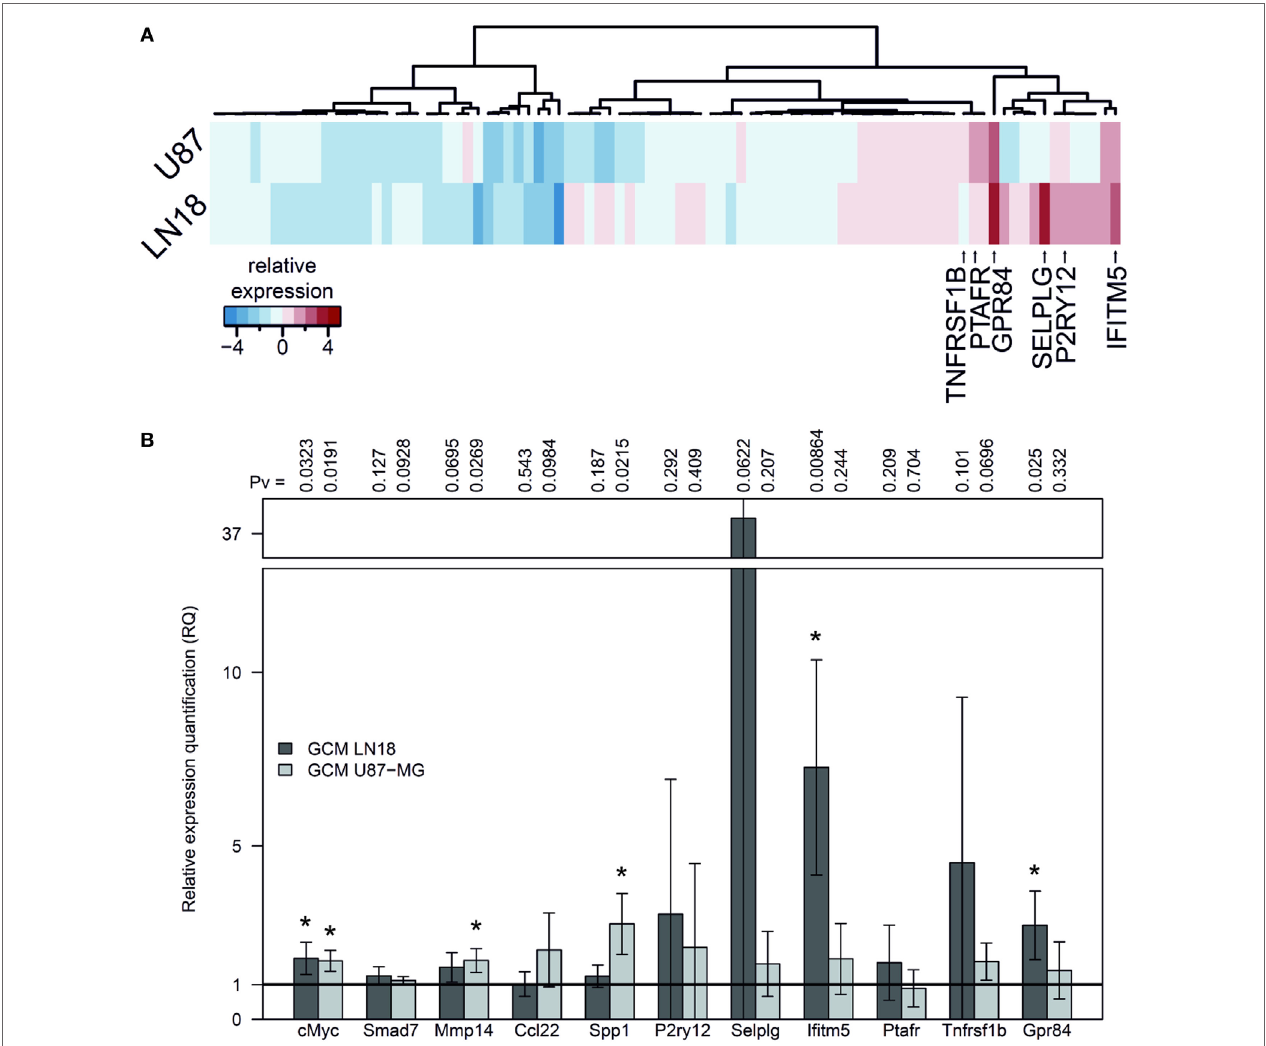
FigUre 3 | Gene expression in human SV40 microglia polarized by factors secreted by human glioma cells. (a) Human Microglial Sensome Gene expression profiling in human SV40 microglia treated by glioma-conditioned medium (GCM) from human LN18 and U87-MG glioma cells was determined with GeneQuery ™ Human Microglial Sensome qPCR Array 6 h after GCM addition. The analysis was performed on assorted samples from three replicates for each group (untreated, stimulated with GCM U87-MG or LN18). Heatmap was generated to represent differentially expressed genes and samples. (B) The expression of selected genes ( cMYC, SMAD7, MMP14, CCL22, and SPP1 ) was validated by qPCR in independent cultures of human SV40 microglia treated with GCM from U87-MG or LN18 cells for 6 h. The results are shown as relative quantification (RQ) of GCM stimulated samples compared with untreated controls. Assessment of statistical significance was performed using one-sample t -test. The results are calculated as means ± SD, n ≥ 3. Differences at p < 0.05 were considered as significant (*** p < 0.001, ** p < 0.01, and * p <